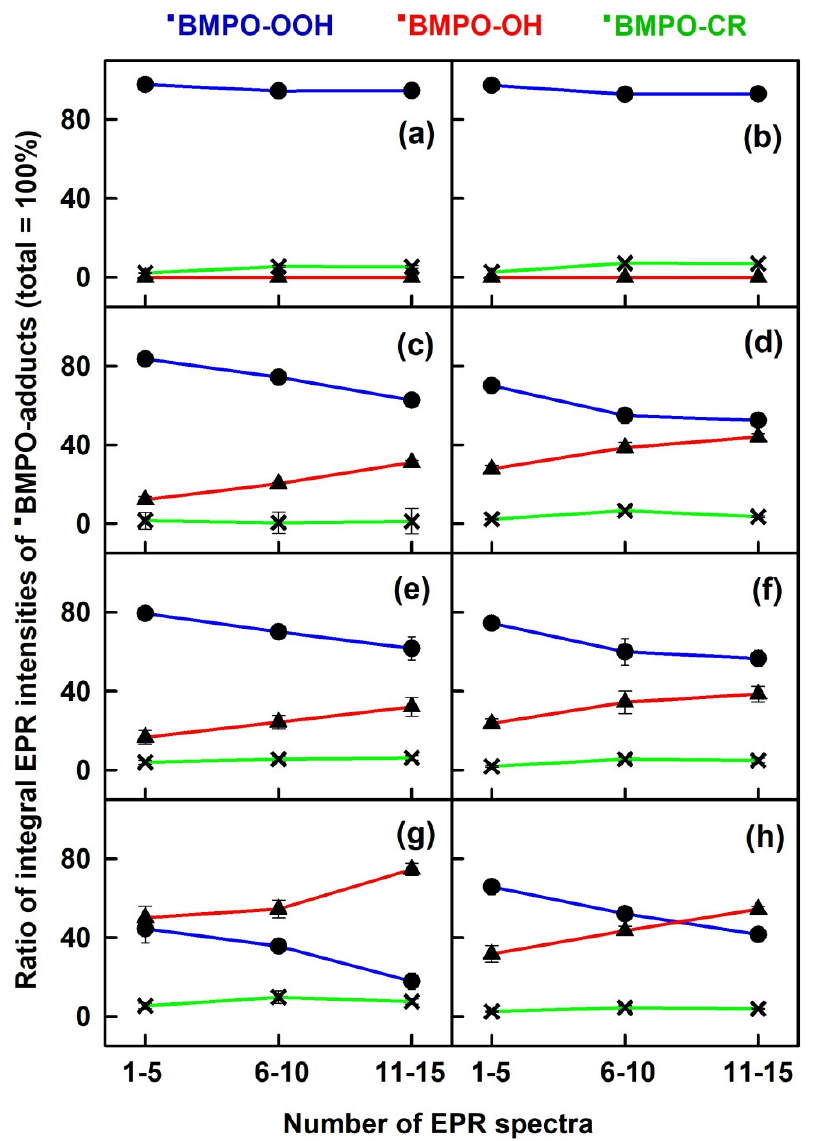
Figure 5. Ratio of normalized integral EPR intensity of individual BMPO-adducts evaluated from experimental spectra simulation. Data calculated from Figure 4. For explanation of ( a–h ) and figure description, see legend to Figure 4.